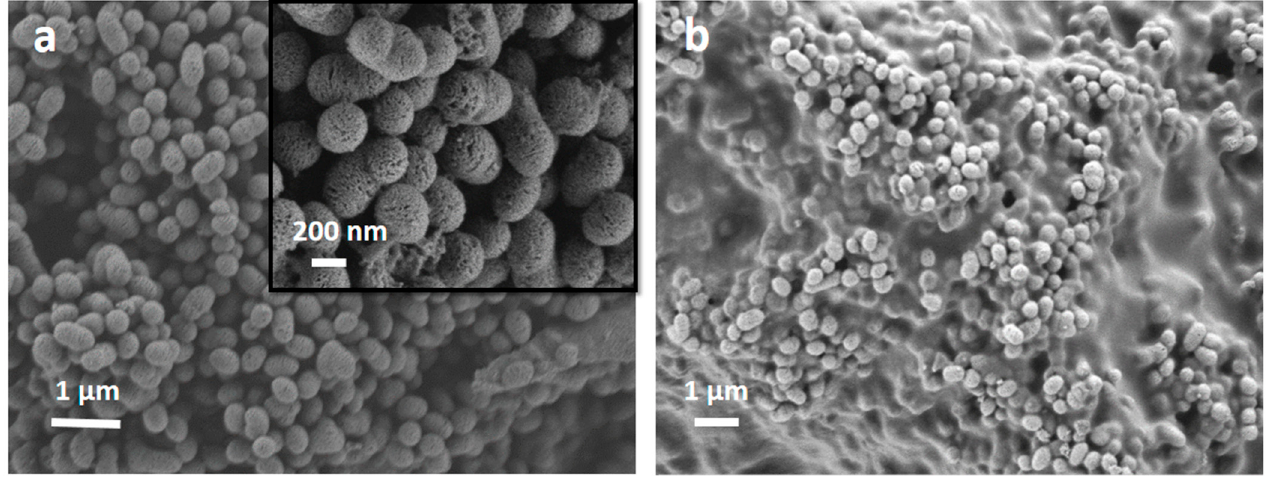
Figure 2. Scanning electron microscopy images of the MBG EOGe particles denoting their porous structure ( a ) and the MBG EOGe particles with chitosan coating showing homogeneous particle size ( b ). The size and distribution of the MBG particles are shown in the box-plots in Figure 3.